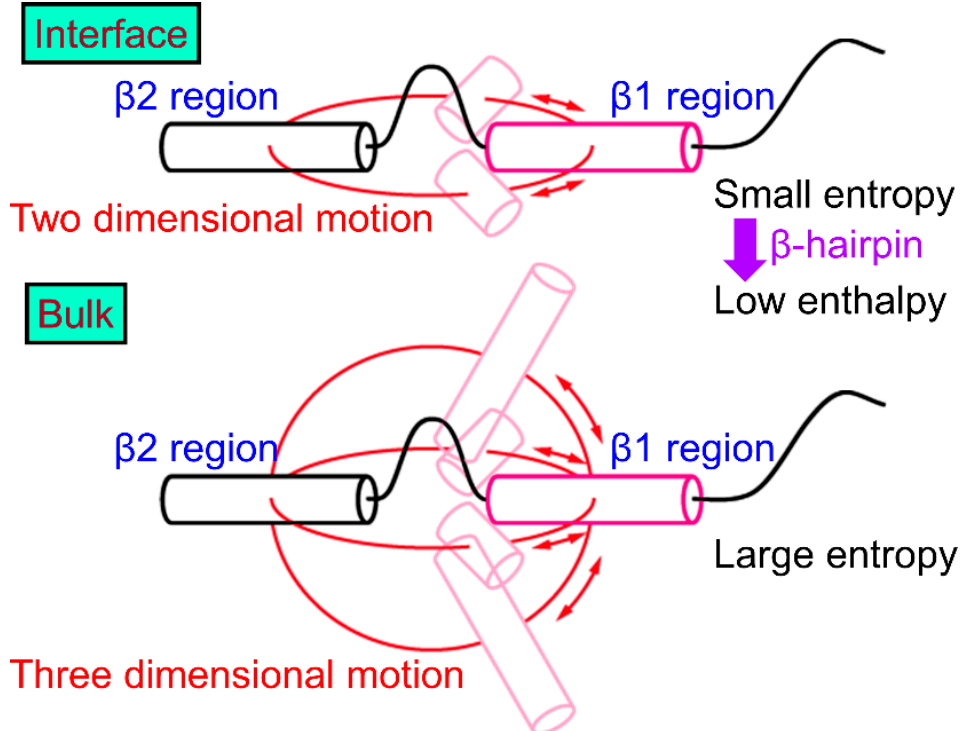
Figure 6. Schematic representation of the conformation of A β 40 at the air–water interface and that in the bulk water. Reprinted with permission from Ref. [30]. Copyright 2019 American Chemical Society.